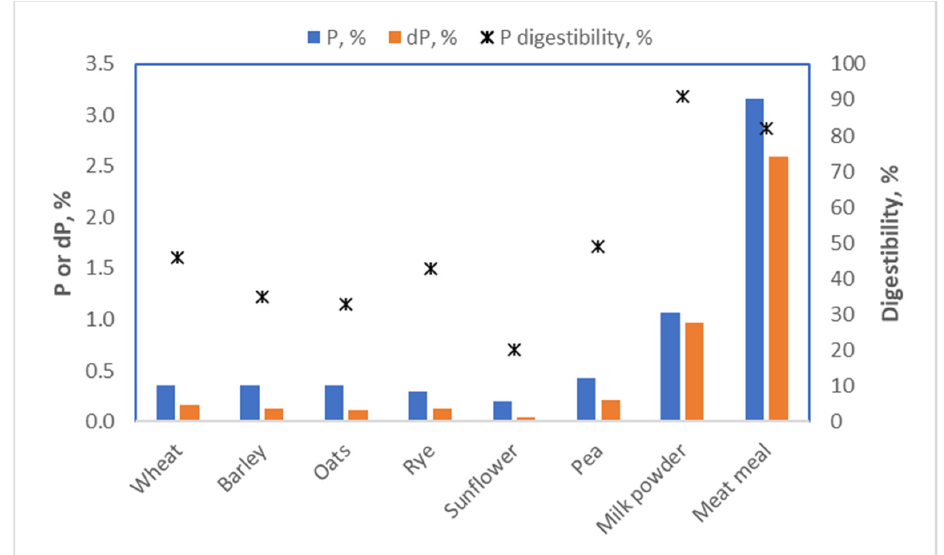
Figure 15. Phosphate (P), digestible phosphate (dP) content and phosphate digestibility coefficients ( ) for some foodstuffs for pigs [9].